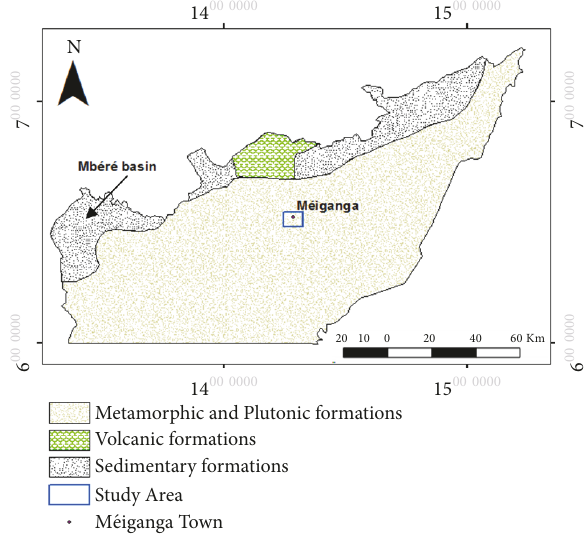
Figure1:MainsaturatedgeologicalformationsintheMb´er´edepart- ment modified from